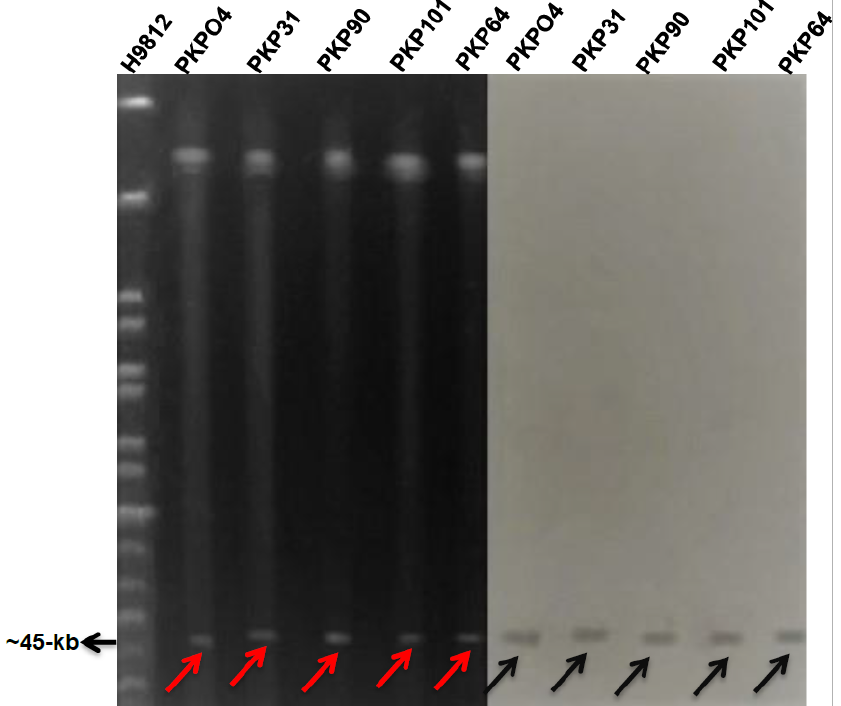
Figure 4. S1 PFGE and Southern blot results. PKPO4, PKP31, PKP90, PKP101, and PKP64 are the isolates, and H9812 is the molecular size marker (1135 to 20.5 kb) digested with Xbal enzymes. Southern hybridization revealed the bla NDM-1 probed on the 45-kb IncX3 plasmid. Black arrows show bla NDM-1 -bearing plasmids on the gel, while red arrows represent bla NDM-1 -harboring plasmids on the nylon membrane .